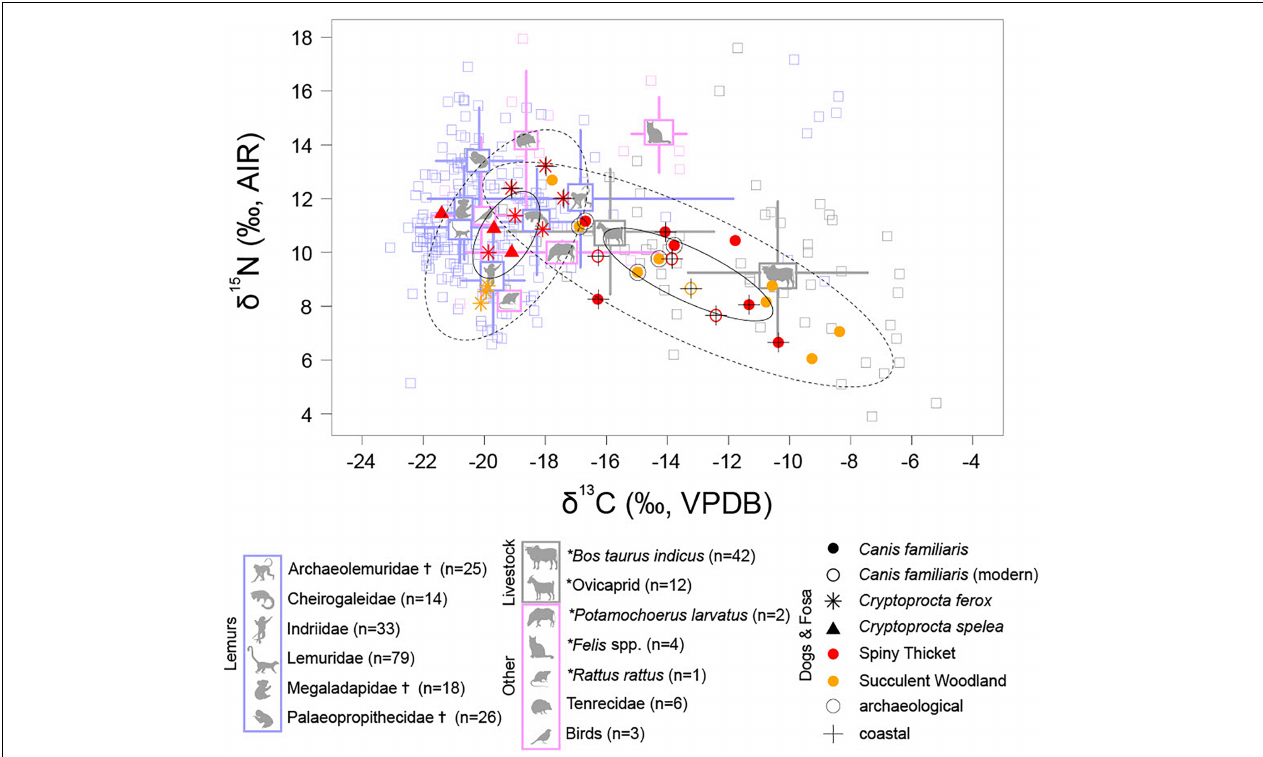
FIGURE 8 | Stable carbon and nitrogen isotope data for bone collagen from dogs (both modern and subfossil) and members of Cryptoprocta (all subfossil) collected in SW Madagascar, with points colored according to ecoregion, shaped according to taxon, and marked according to deposit type ( n = 36, see Figure 5 explanation of ellipses fitted to dog and Cryptoprocta spp. data). Stable isotope data from the bone collagen of lemurs, livestock, and other animals collected in SW Madagascar are plotted for reference, with icons marking means and lines marking standard deviations in δ 13 C and δ 15 N values. Note that extinct families of giant lemurs are marked with ( † ), introduced taxa are marked with (*), and modern individuals (including six modern dogs) have δ 13 C values that are corrected for the Suess Effect (following Crowley and Godfrey, 2013) so that they are comparable with subfossil collagen values. Also note that dog and Cryptoprocta spp. δ 13 C and δ 15 N values are shifted by –0.5 and –3